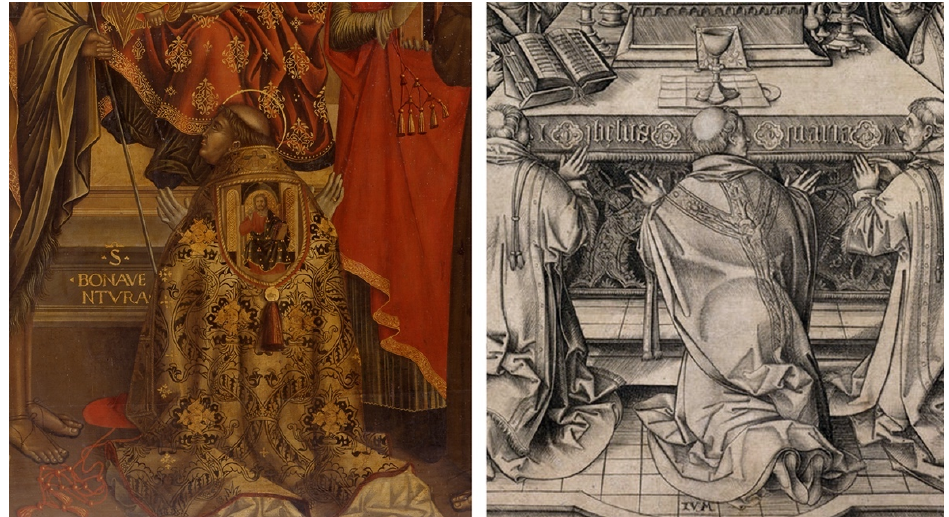
Figure 13. Angelos Bitzamanos. Saint Bonaventure (detail from the Scottivoli altarpiece), 1508. Vatican, Apostolic Palace ( left ) © Musei Vaticani. Reproduced with permission; Israhel van Meckenem, The Mass of Saint Gregory (detail), ca. 1490 ( right ). Image in the public domain; Figure created by author.